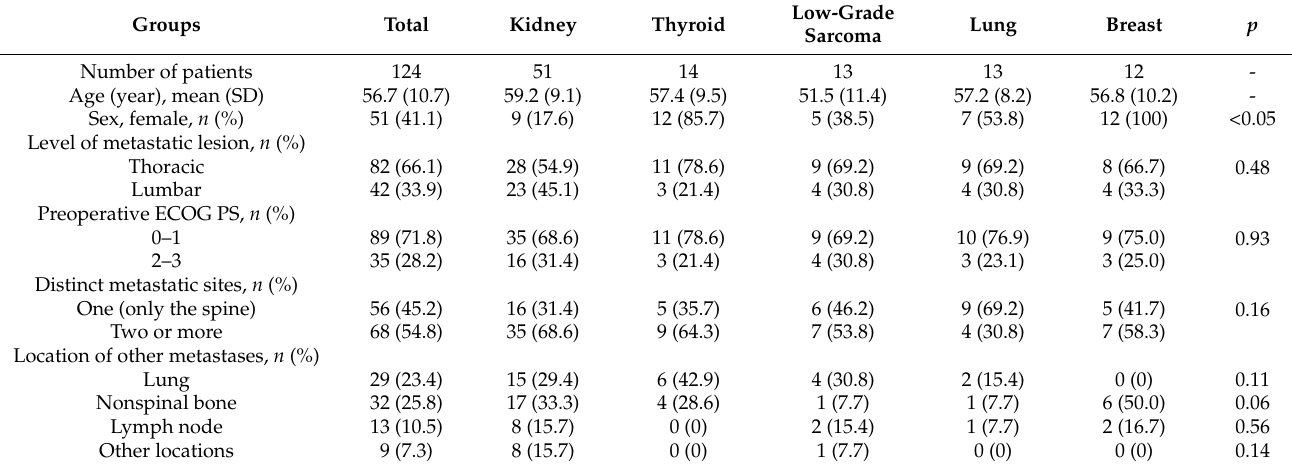
Figure 2. Study flow chart. Table 1. Background characteristics of the patients who underwent spinal